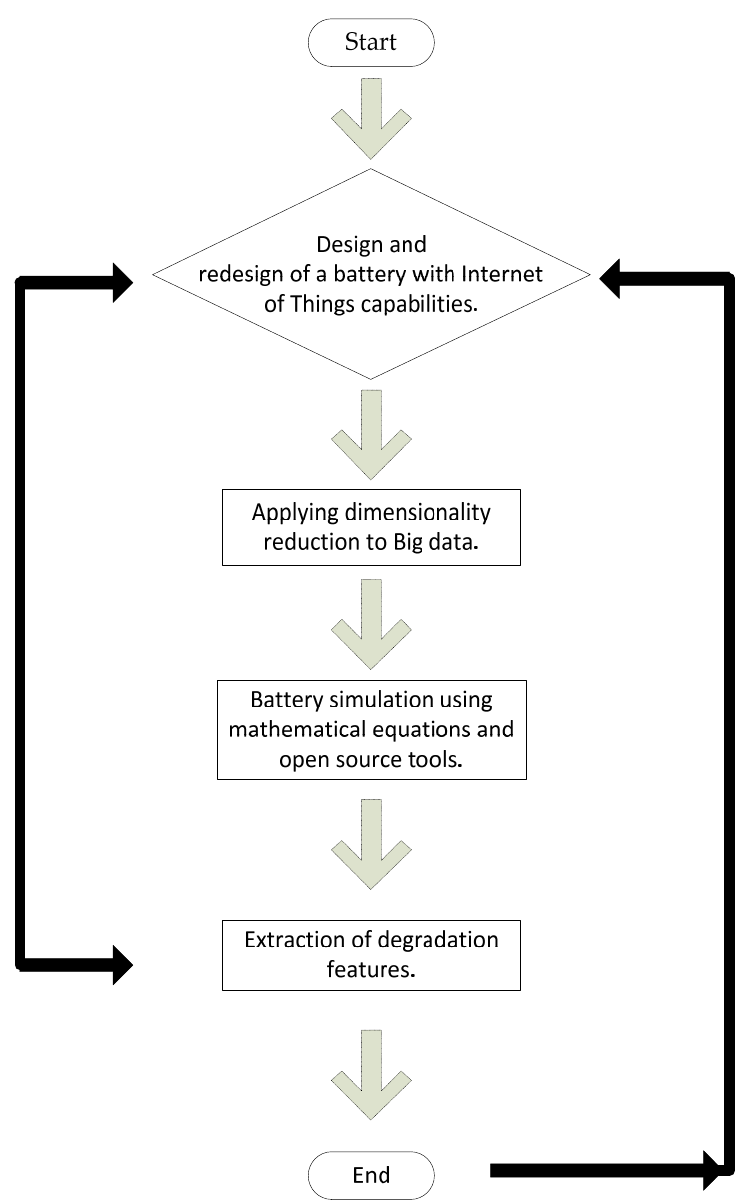
Figure 1. Iterative procedure for defining the parameters that are critical in determining the rate of degradation and, as a result, optimizing the performance of newly made